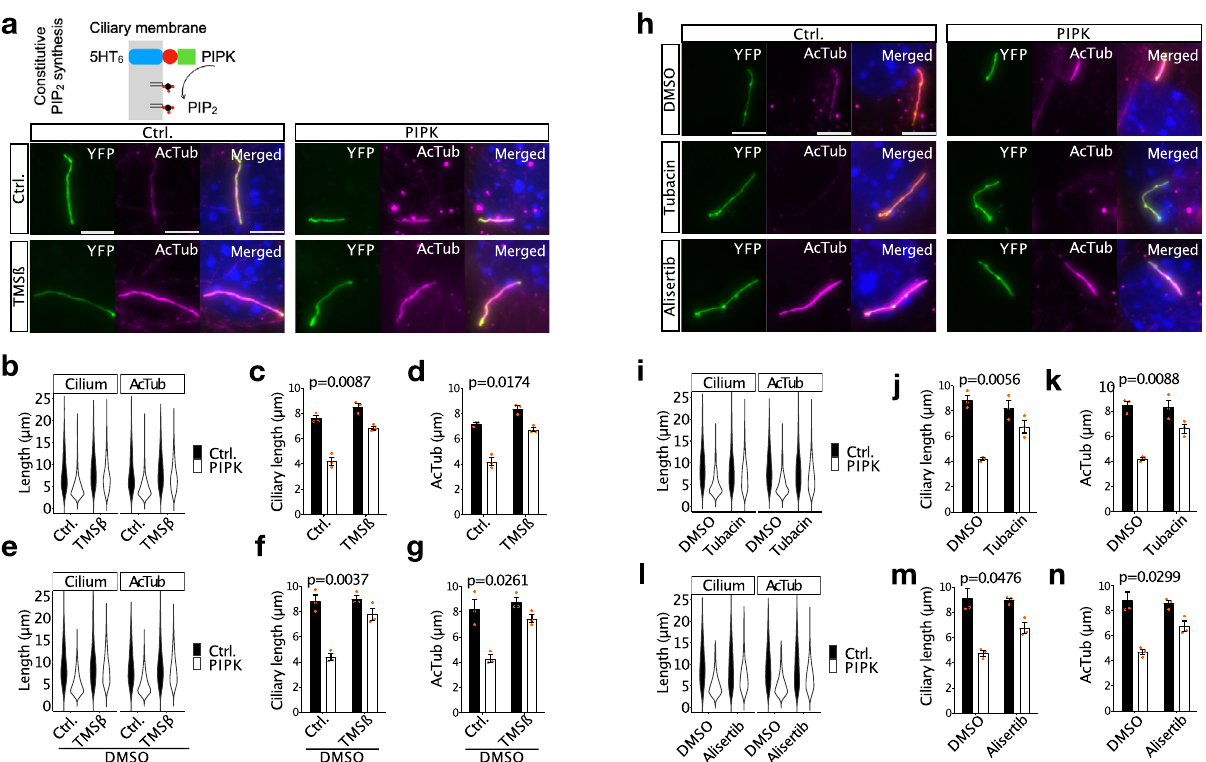
Fig. 6 Constitutively increasing PIP 2 leads to short cilia. a Examples of NIH3T3 cells expressing 5HT 6 -mCherry-PIPK (right), to constitutively increase ciliary PIP 2 , or 5HT 6 -mCherry (left), as a control, and in addition 5HT 6 -YFP-TMS β (bottom), to depolymerize ciliary actin, or 5HT 6 -YFP (top), as a control. Cells were fi xed 48 h after transfection after 18 – 20 h of starvation. They were stained against acetylated tubulin (AcTub). Scale bars are 5 µ m. b Violin plot showing all cilia from 3 independent experiments: 241 for Ctrl./Ctrl., 241 for PIPK/Ctrl., 241 for TMSß/Ctrl., 241 for PIPK/TMSß. c , d Medians of the n = 3 independent experiments summarized in ( b ), reporting ciliary length by YFP ( c ) and acetylated tubulin (AcTub, d ). p values are for the interaction of factors PIPK vs. Ctrl. and TMSß vs. Ctrl. in two-way ANOVA. e – g Quanti fi cation of experiments as in ( a – d ), but in the presence of 2 µ M DMSO added with the starvation medium (18 – 20 h before fi xation). e All cilia: 223 for Ctrl./Ctrl., 223 for PIPK/Ctrl., 223 for TMSß/Ctrl., 223 for PIPK/TMSß. h Examples of NIH3T3 cells expressing 5HT 6 -mCherry-PIPK (right) or 5HT 6 -mCherry (left) and in addition 5HT 6 -YFP. Cells were exposed to DMSO only (top), 2 µ M Tubacin (middle), or 200 nM Alisertib (bottom) added with the starvation medium 18 – 20 h before fi xation. Scale bars are 5 µ m. Note that AcTub staining is weaker with tubacin treatment; all images are exposed for the same time. i All cilia: 184 for Ctrl./DMSO, 184 for PIPK/DMSO, 184 for Ctrl./Tubacin, 184 for PIPK/Tubacin. j , k Medians of the n = 3 independent experiments in ( i ). p values are for the interaction of factors PIPK vs. Ctrl. and Tubacin vs. DMSO in two-way ANOVA. l All cilia: 175 for Ctrl./DMSO, 175 for PIPK/DMSO, 175 for Ctrl./Alisertib, 175 for PIPK/Alisertib. m , n Medians of the n = 3 independent experiments in ( l ). p values are for the interaction of factors PIPK vs. Ctrl. and Alisertib vs. DMSO in two-way